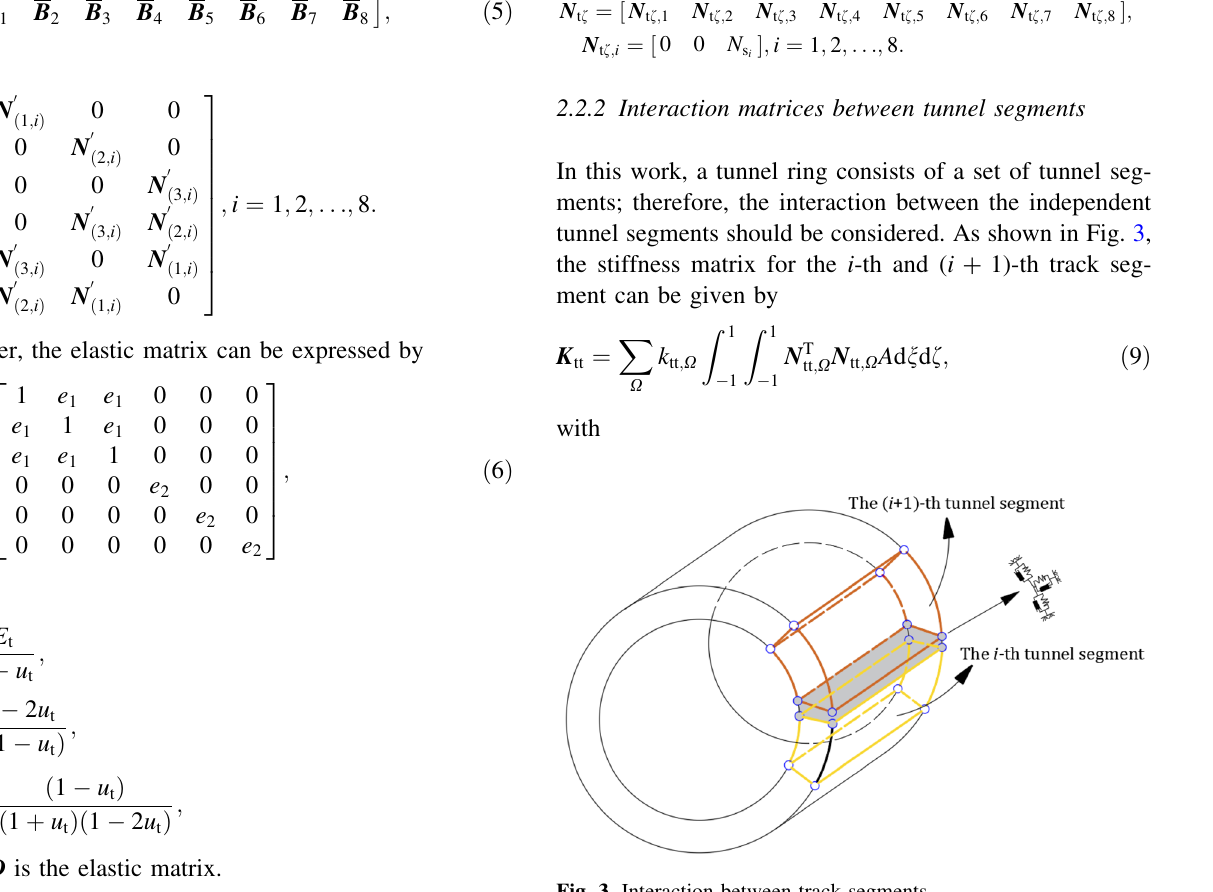
Fig. 3 Interaction between track